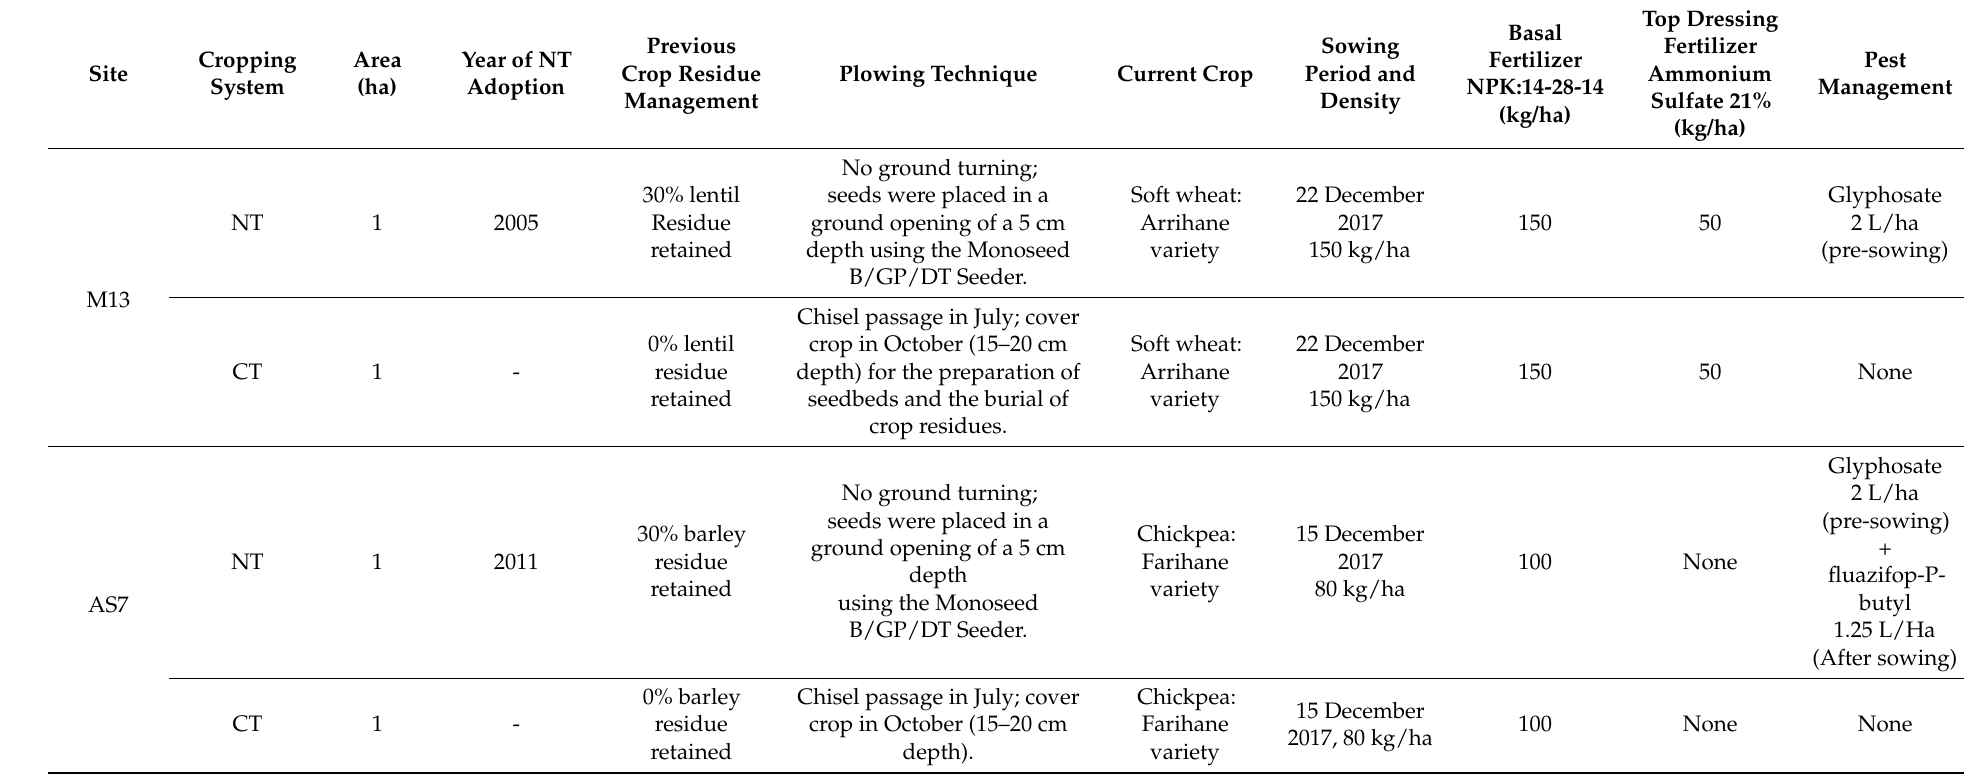
Table 2. Management history of the experimental